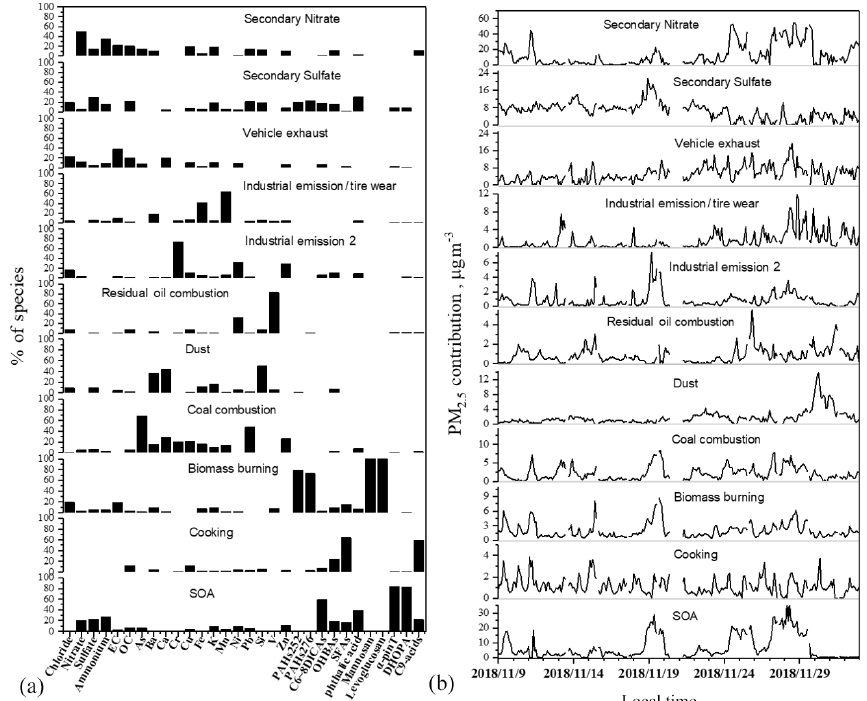
Figure 3. Individual source profiles of the 11 factors resolved in the constrained MM-PMF run (a) and time series of individual factor contributions (b)